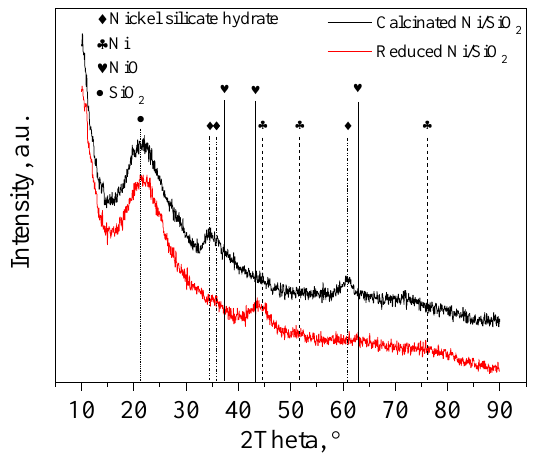
Figure 3. X-ray diffraction (XRD) patterns of calcinated and reduced catalysts.